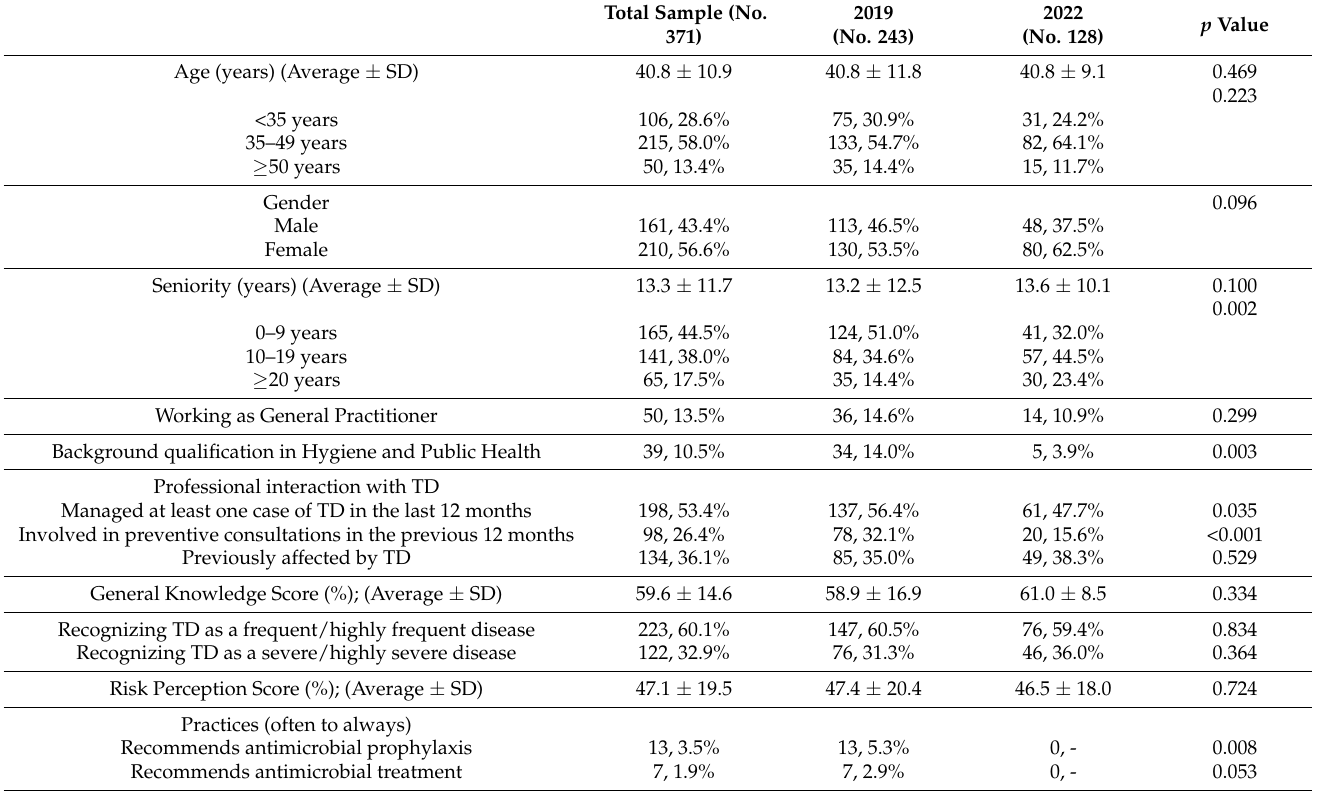
Table 1. General characteristics of the 371 Italian Occupational physicians in Italy participating in the study on travelers’ diarrhea (TD) (2019 vs. 2022). Continuous variables were compared by means of Mann–Whitney U test, while categorical ones were compared through chi-squared test. Total Sample (No. 2019 2022 371) (No. 243) (No.